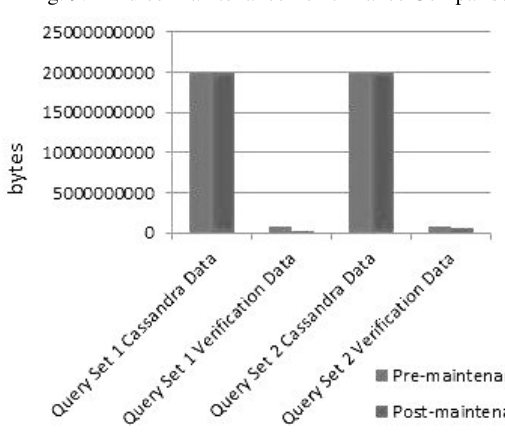
Fig. 9. Xindice Maintenance Performance Comparison